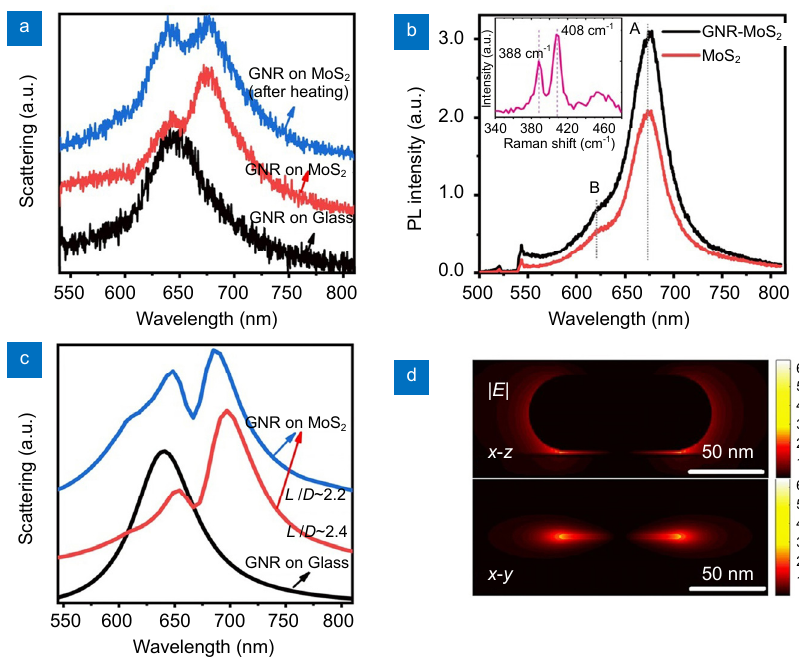
Fig. 3 | ( a ) Normalized scattering spectra of a GNR on glass (black), the same GNR moved onto MoS 2 (red), and the GNR on MoS 2 after heating (blue). ( b ) Photoluminescence spectra of MoS 2 monolayer without (red) and with (black) GNR. The black dashed line in (b) marks the A (right) and B (left) excitons absorption peak. Inset: Raman spectra of MoS 2 monolayer with the A 1g peak (408 cm − 1 ) and E 2g 1 peak (388 cm − 1 ). Excitation laser wavelength: 532 nm. Excitation power: 110 μ W. Integration time: 0.5 s. ( c ) Calculated scattering spectra using the FDTD method corre- sponding to the experimental spectra shown in (a). Scattering spectra of a GNR ( L / D ~2.4) on glass (black), the same GNR ( L / D ~2.4) on MoS 2 (red) and another GNR ( L / D ~2.2) on MoS 2 (blue). ( d ) Near-field distributions: the calculated near-field distribution | E | in the x - z plane ( y =0 nm) (upper) and in the x - y plane ( z =0 nm) (lower), i.e., the interface between GNR and MoS 2